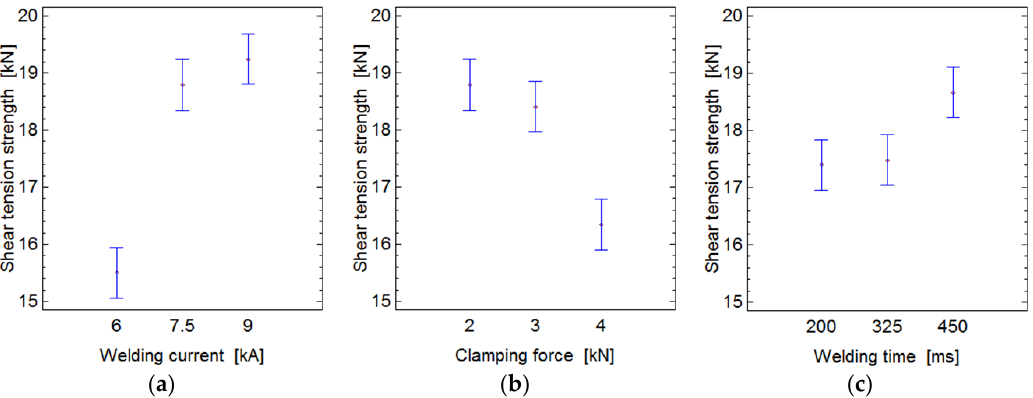
Figure 8. Mean shear tension strength and standard error (95% confidence intervals) for each level of the welding parameters: ( a ) welding current; ( b ) clamping force; and ( c ) welding time.